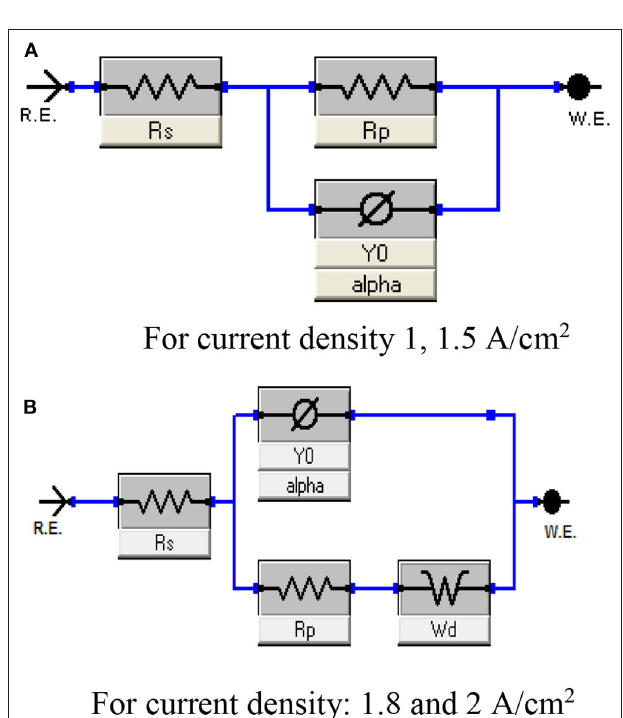
FIGURE 8 | Equivalent circuit represents the behavior of porous Ni–Cu electrodeposited layers in 1M KOH solution at 25 ◦ C. (A) For current density 1, 1.5 A/cm 2 , (B) For current density: 1.8 and 2 A/cm 2